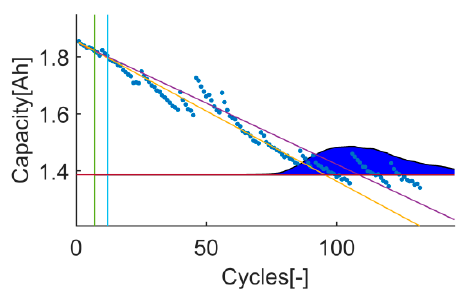
Figure 19. Time-instant figure of test 2 on t 1 .